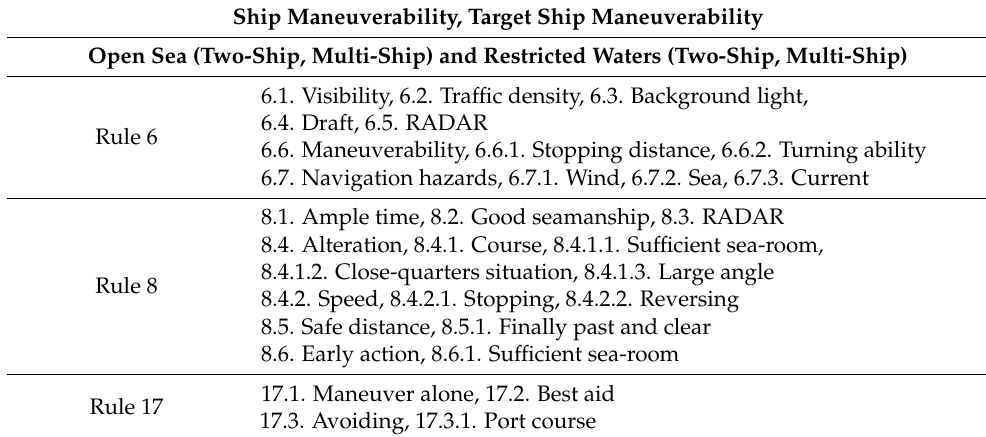
Table 5. Requirements analysis for ship